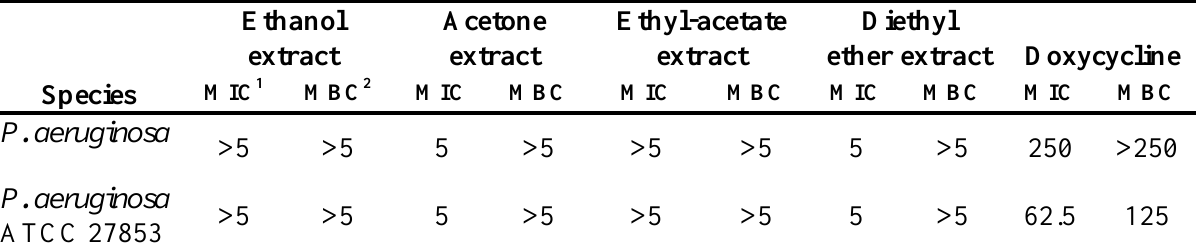
Table 3. Antibacterial activity of extracts from P.